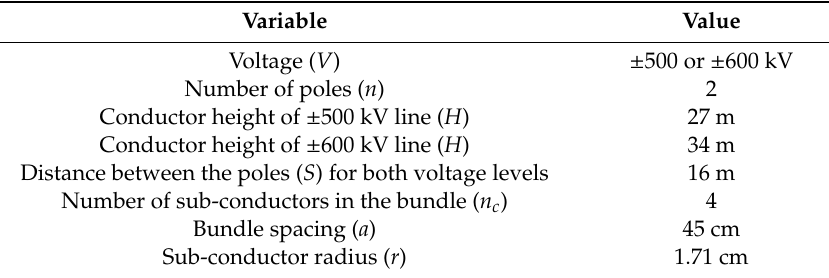
Table 2. Data of the HVDC lines considered in the simulations.